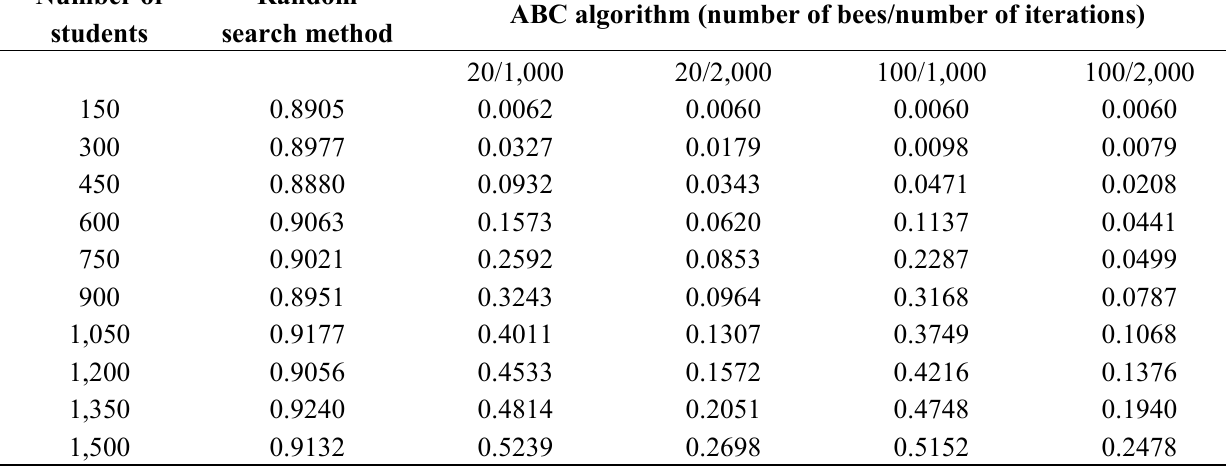
Table 2. Comparison of average best fitness values for the random search method and the ABC algorithm.